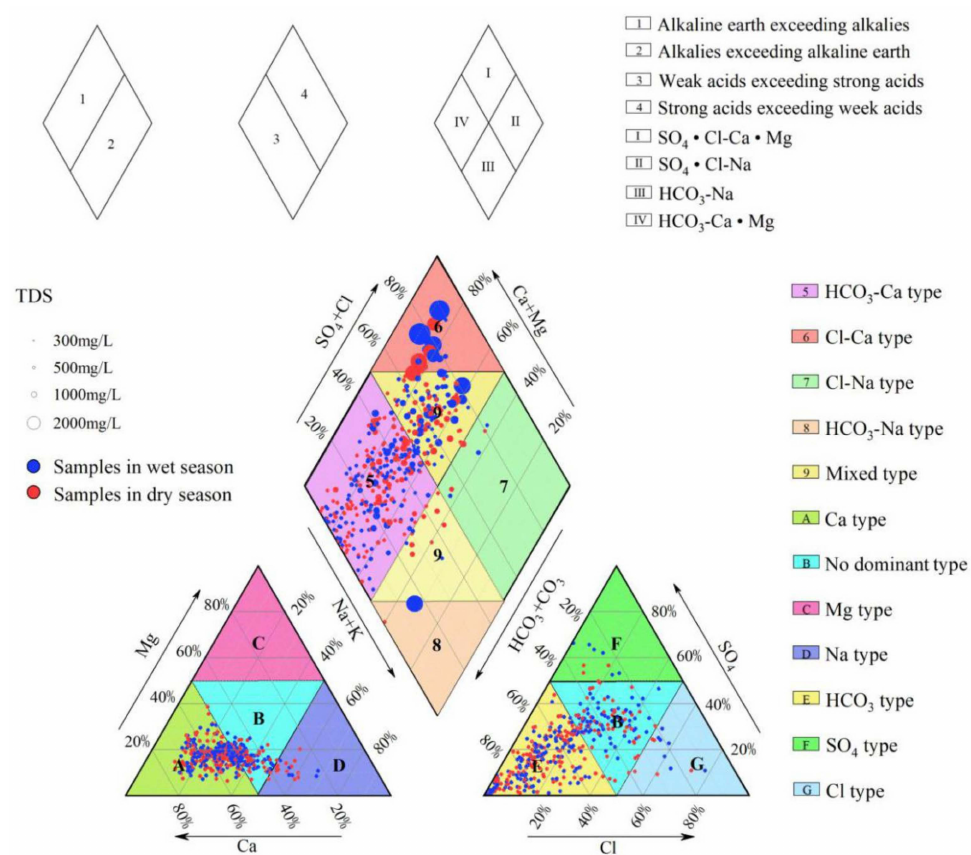
Figure 2. Piper diagram for the